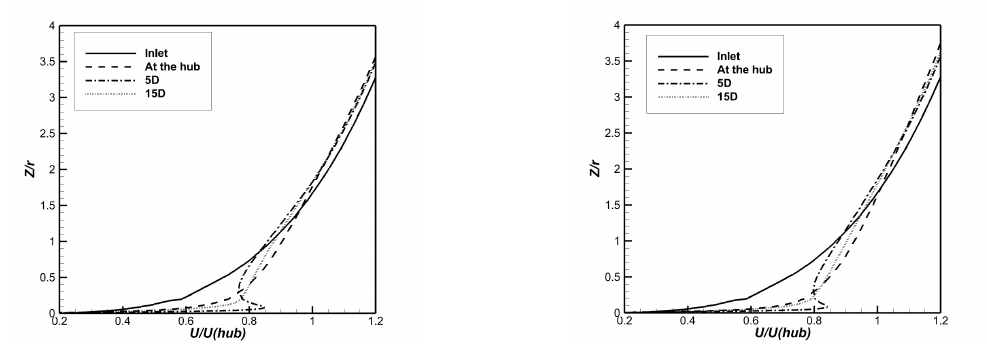
Figure 3. Development of power law ( left ) and logarithmic velocity profile ( right ) in the absence of the actuator